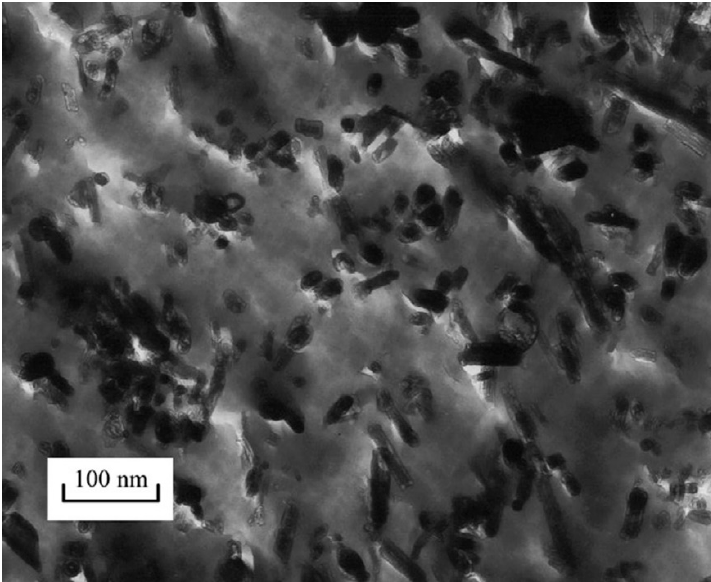
Figure 17. SEM photomicrograph of the surface of PIPAA-PM/SNT nanocomposite film (volume fraction of SNT is 19.6%) [4].